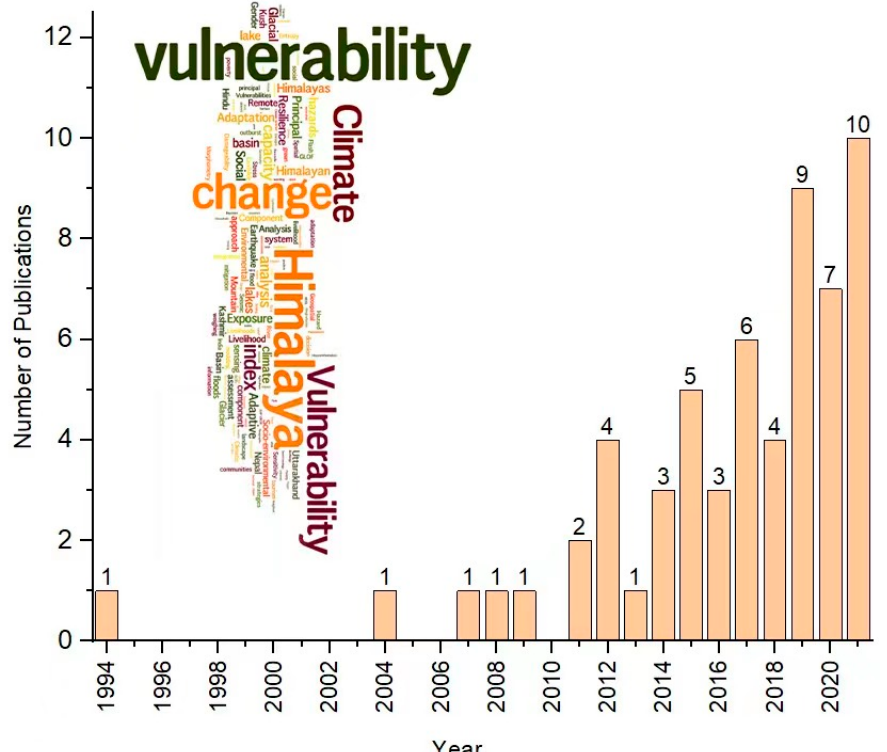
Figure 4. The number of peer-reviewed publications on vulnerability in the Himalayan region between 1994 and 2021. Note: The word cloud is based on the keywords found in the sampled papers. It was created with Wordle (http://www.wordle.net/; accessed on 20 January 2022). The word size reveals the relative frequency of their occurrence .